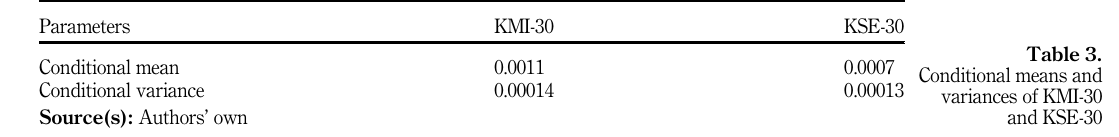
Table 3. Conditional means and variances of KMI-30 and